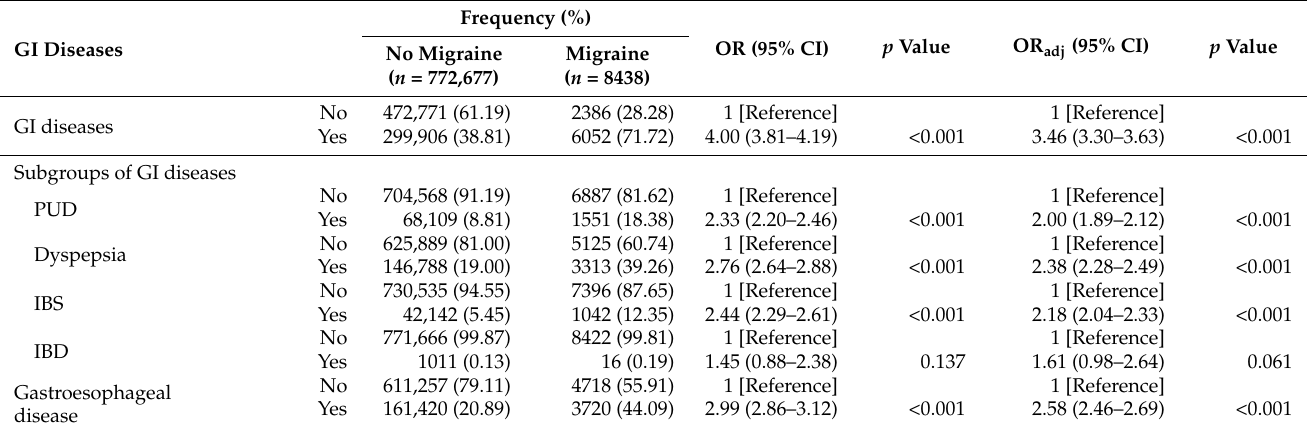
Table 2. The association between migraine and gastrointestinal diseases.